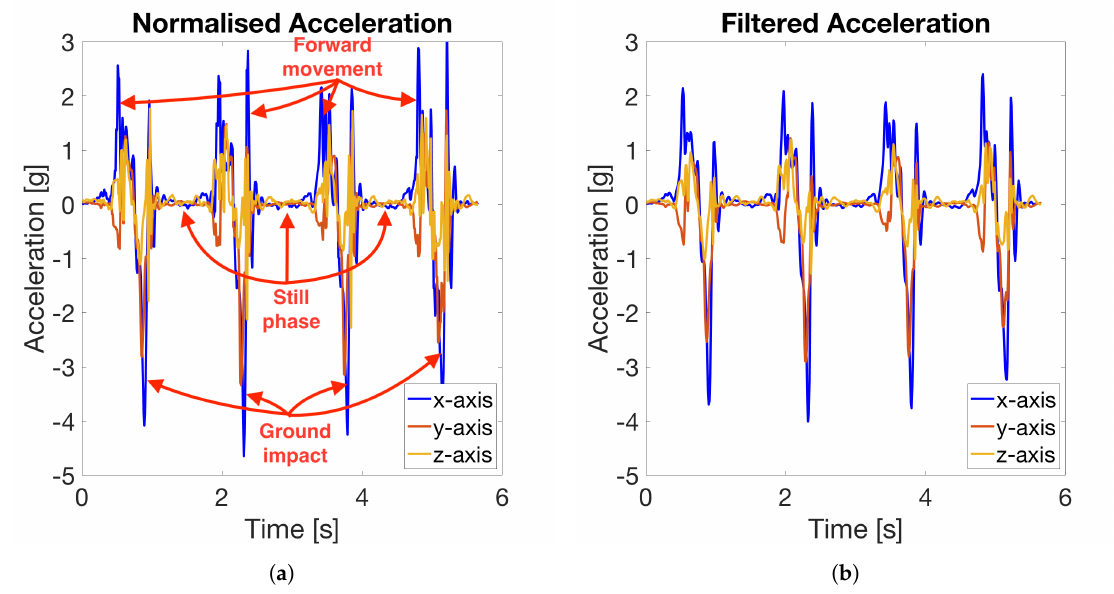
Figure 5. Raw acceleration ( a ) and low-pass filtered acceleration ( b ) for four strides. Forward movements during a stride cause a positive acceleration along the x -axis. Hoof impacts with the ground can be seen as peaks in the acceleration, particularly along the x - and y -axes. Periods while the hoof is in contact with the ground (still phases) have almost zero